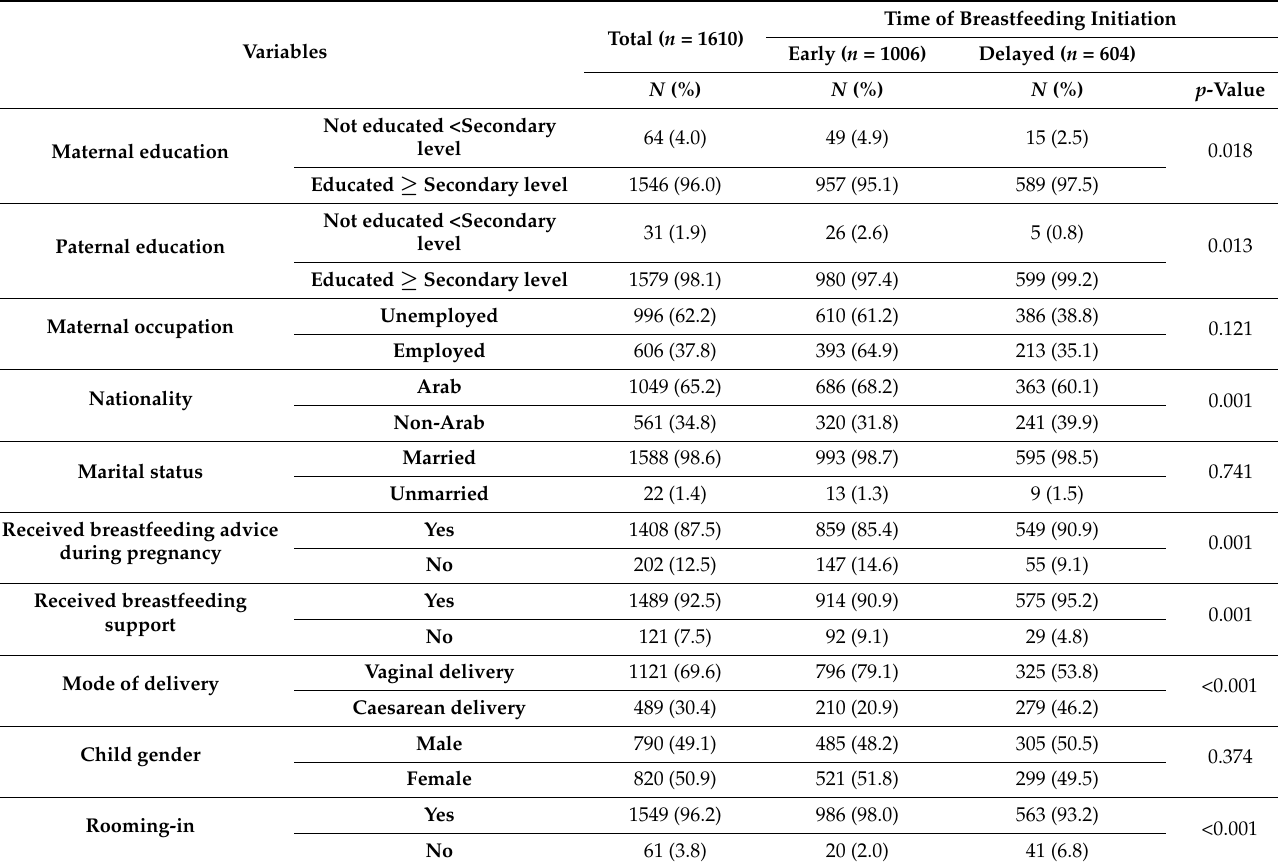
Table 2. N (%) of the sociodemographic characteristics of the participants ( n = 1610) using chi-square